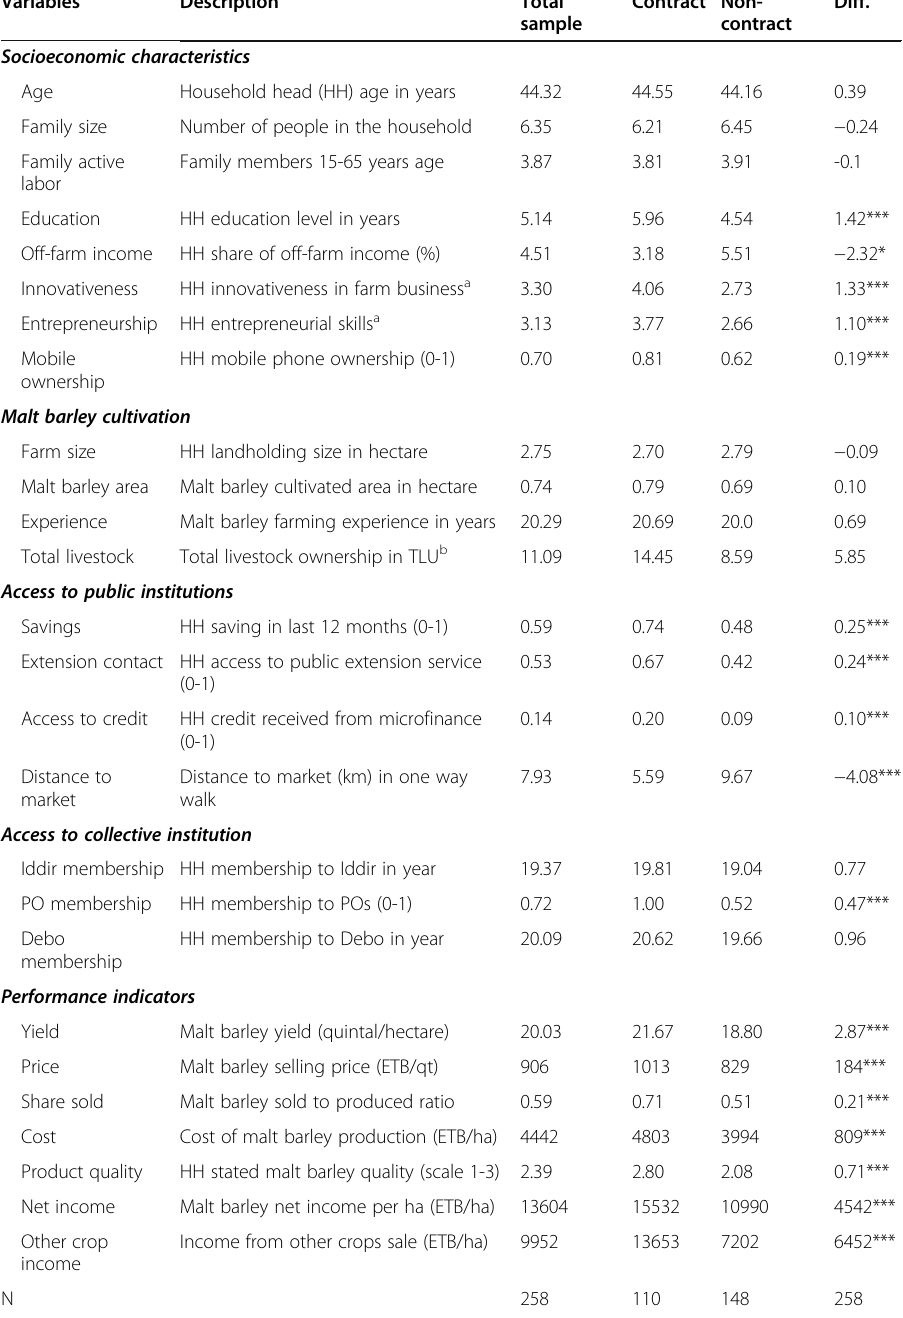
Table 1 Characteristics of contract and non-contract malt barley farmers Variables